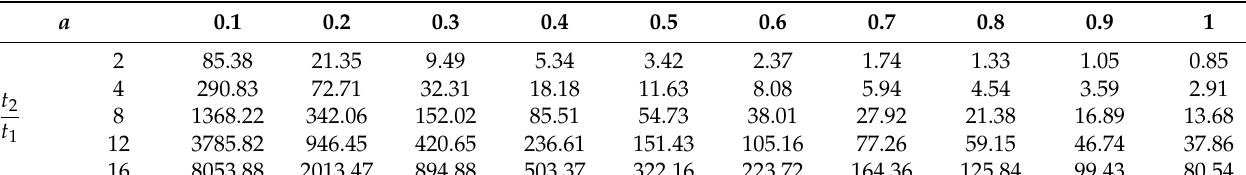
Figure 7. Buckling loads affected by loading frequency. Table 3. Buckling loads vs. core layer’s thickness.